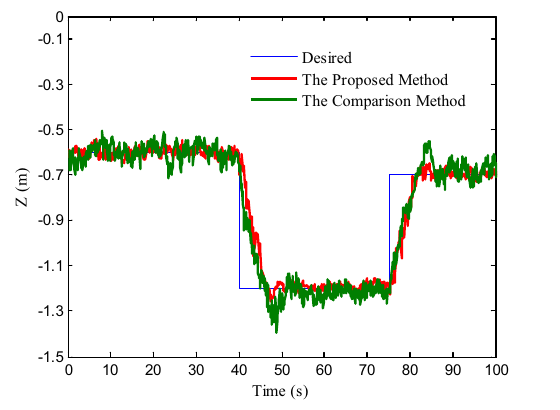
a Trajectory tracking of 0.3 m/s ocean current environment